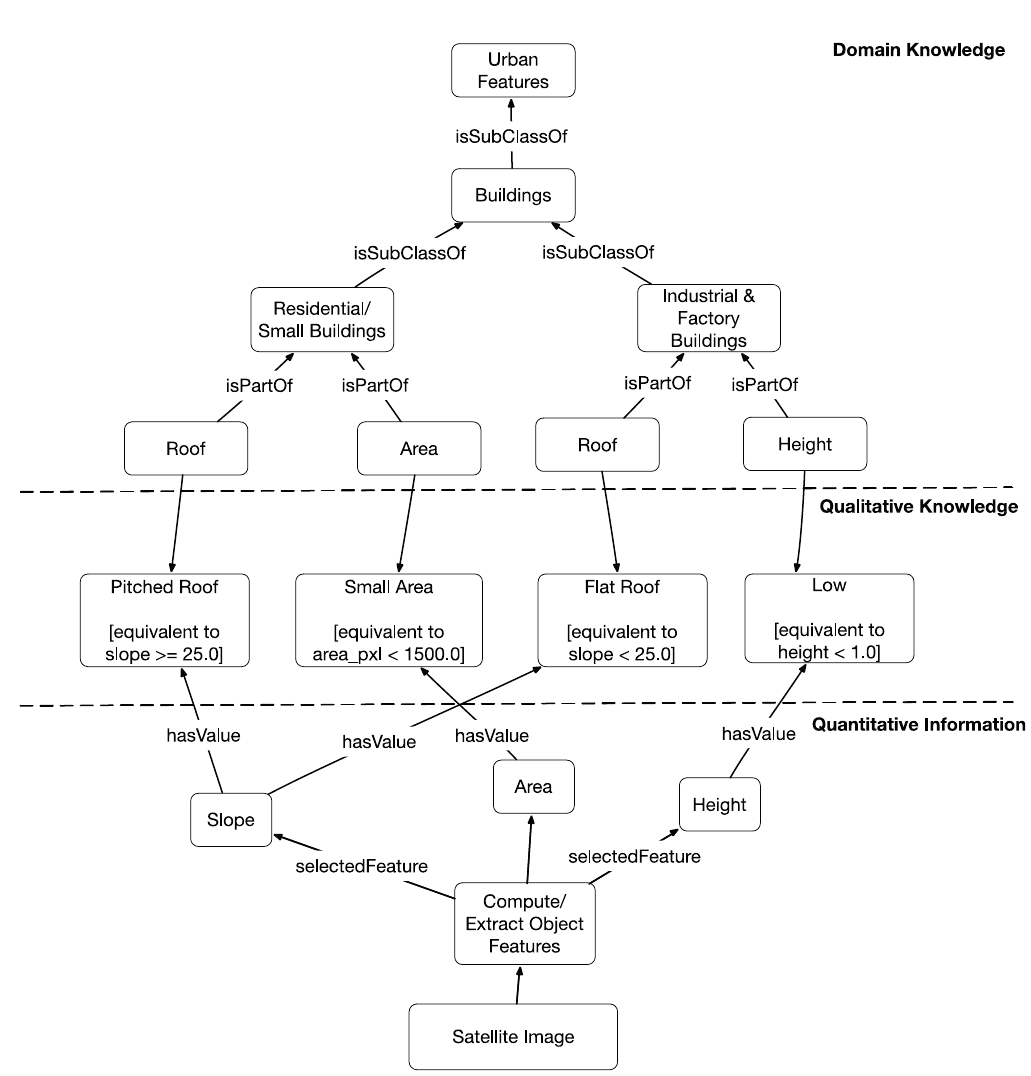
Figure 2. Structure of applied ontology for the classification